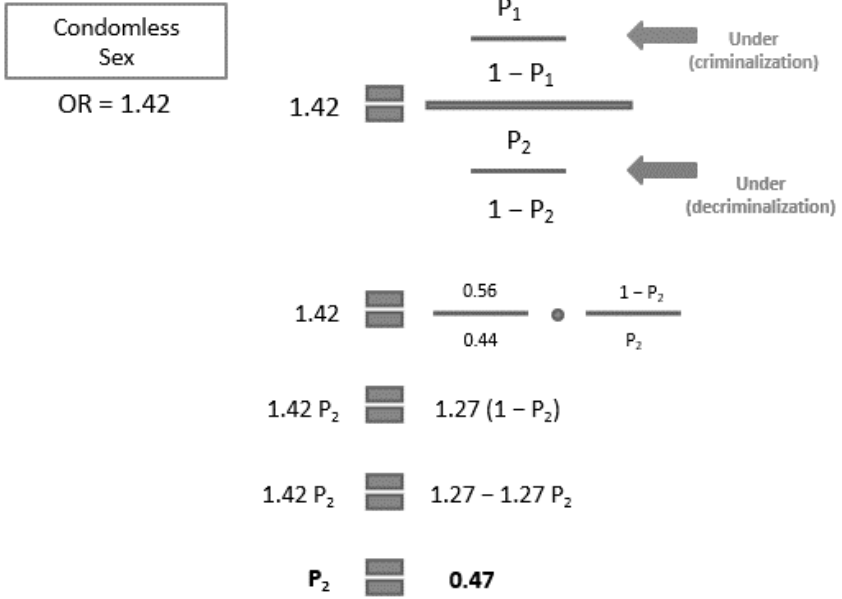
Figure A2. Prevalence of condomless sex after decriminalization.